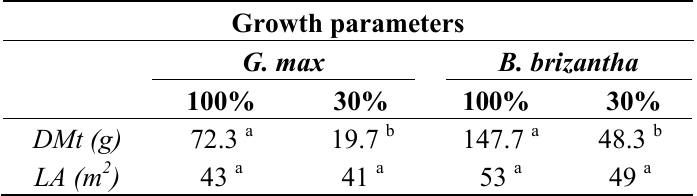
/F ) and effective (∆F/F ’ ) photosystem II (PSII) v m m